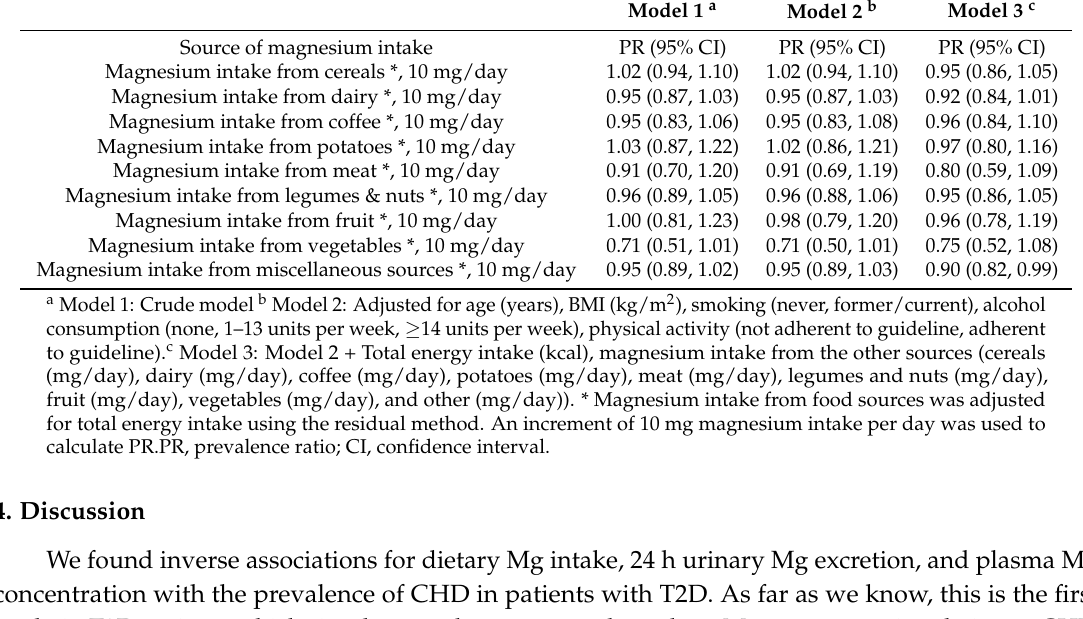
Figure 1. Sources of magnesium intake from different food product categories in patients with T2D. Table 3. Prevalence ratios (95% CI) for associations between magnesium intake from different food sources in type 2 diabetes patients from the DIALECT cohort ( n = 450).